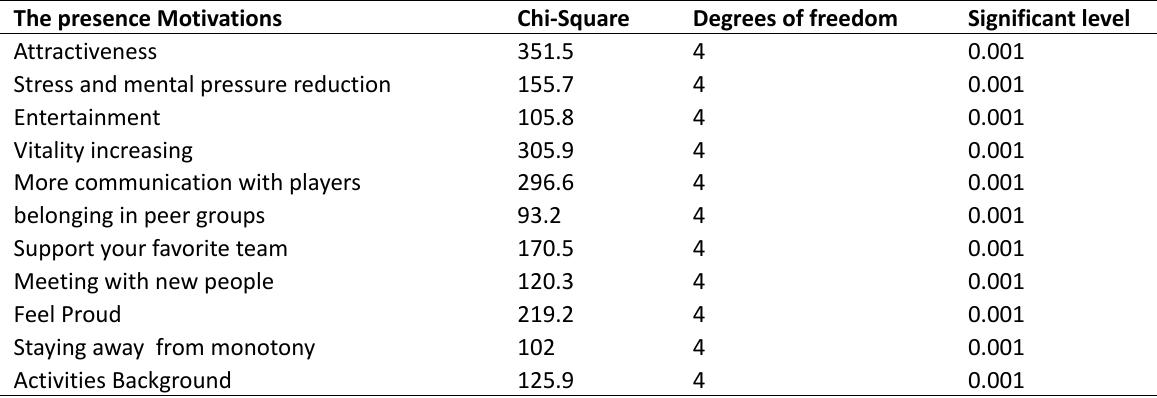
Table 3. The results of chi-square test for the motivations to watch tournaments in sporting venues